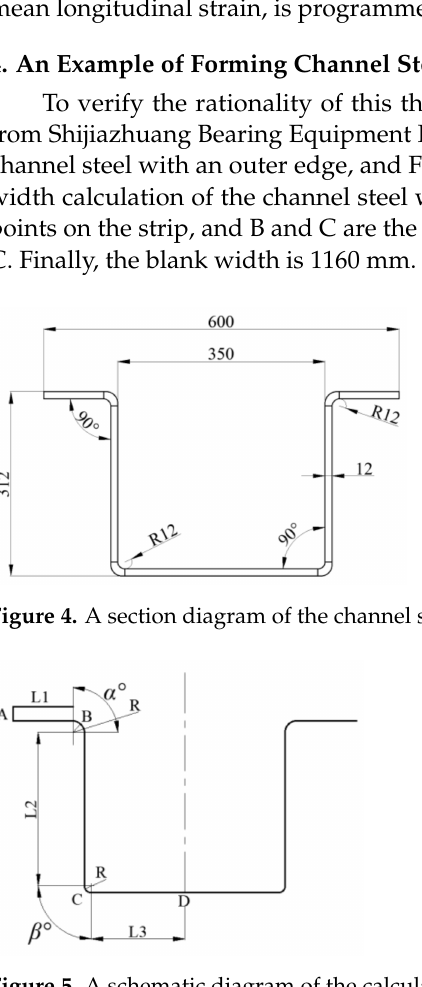
Figure 5. A schematic diagram of the calculation of the channel steel with an outer